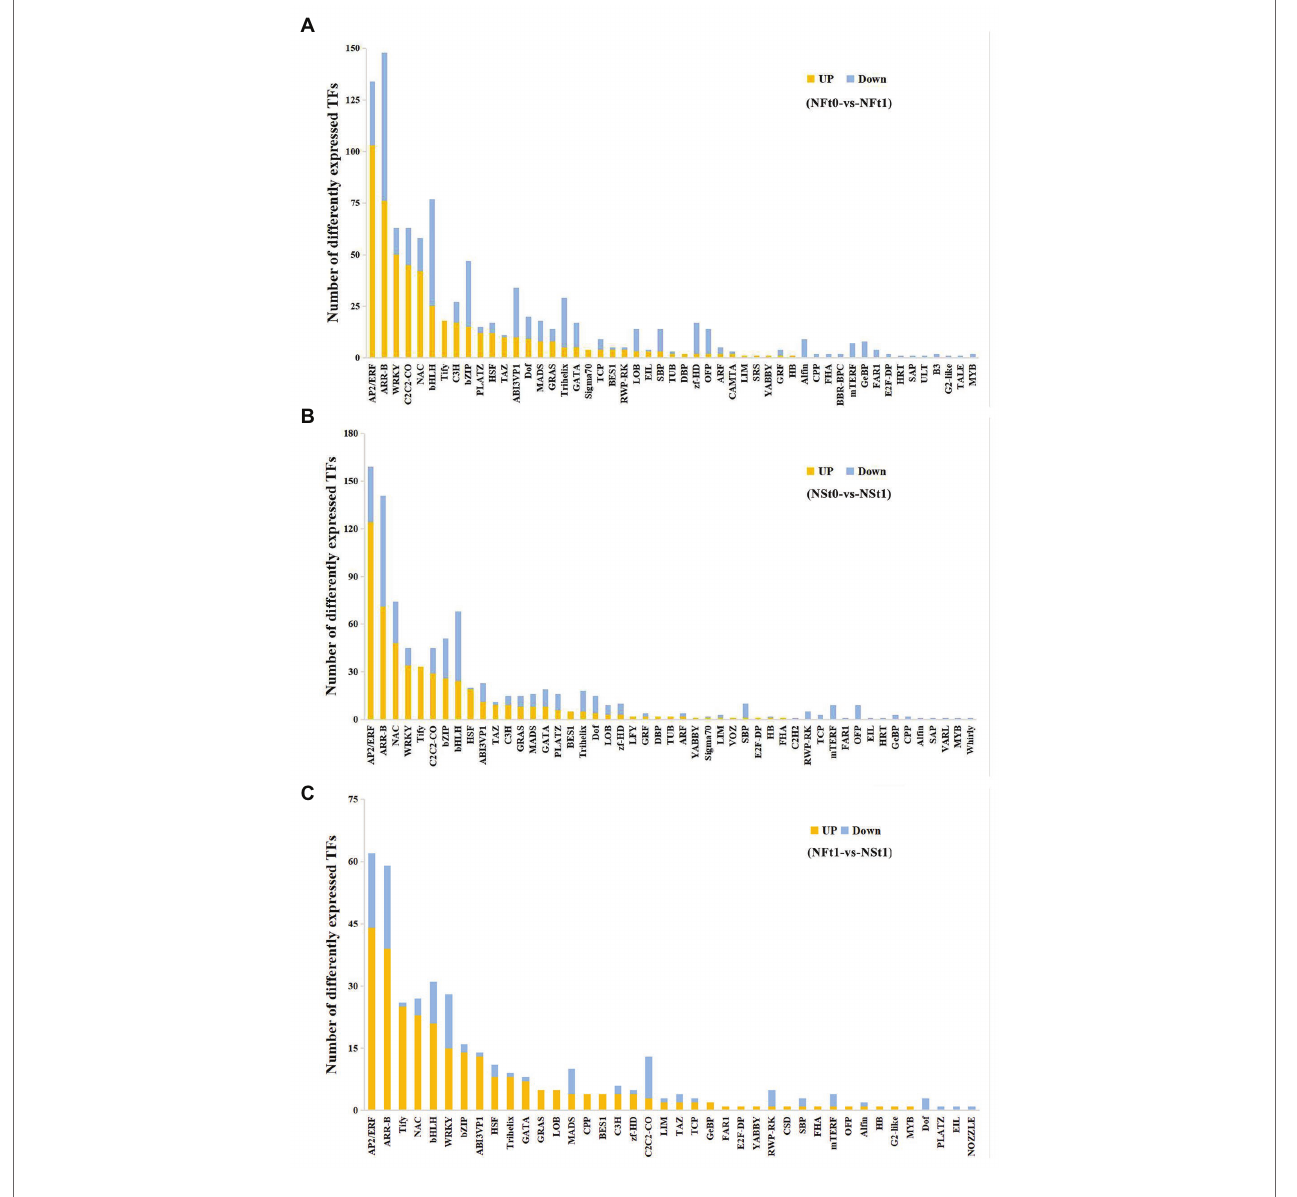
FIGURE 6 | Classification of differentially expressed transcription factors (TFs) in developing rapeseed leaves. TFs identified in the leaf transcriptome of rapeseed cultivar NF (A) and NS (B) under freezing stress, respectively. (C) The unique TFs identified in leaf transcriptome between both cultivars at freezing treatment time of